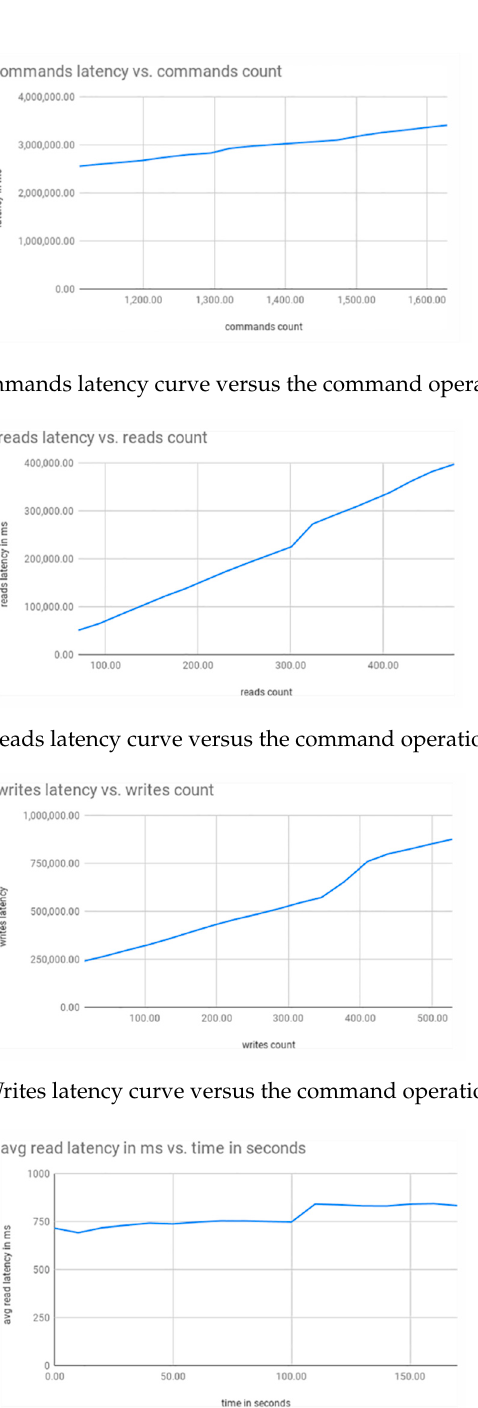
Figure 13. Commands latency curve versus the command operations count.